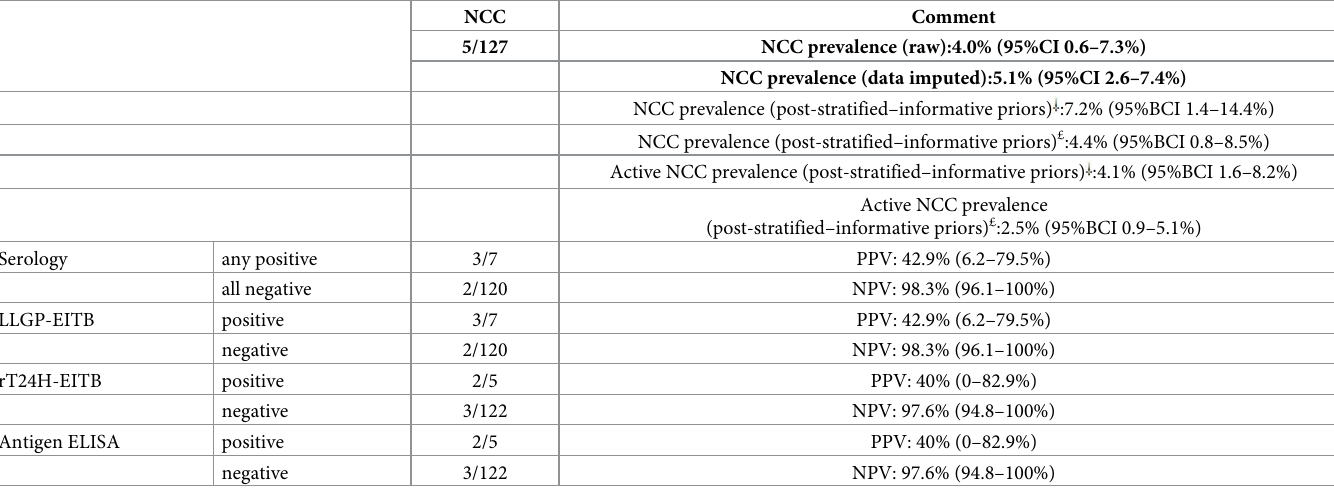
Table 4. NCC diagnosis and serological findings among patients with epilepsy in rural Balaka district,